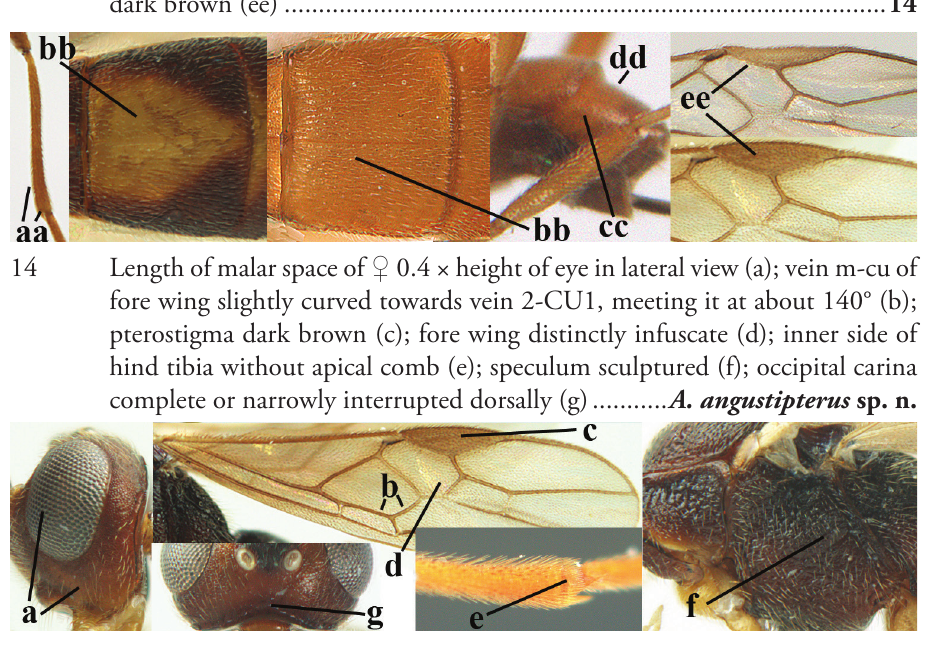
– Length of malar space of ♀ 0.5 × height of eye in lateral view (aa); vein m-cu of fore wing straight and angled to vein 2-CU1 (bb); pterostigma yel- lowish (cc); fore wing subhyaline (dd); inner side of hind tibia with weakly developed apical comb (ee); speculum partly smooth and shiny (ff); occipital carina widely interrupted dorsally (gg) ......................... A. carminatus sp.